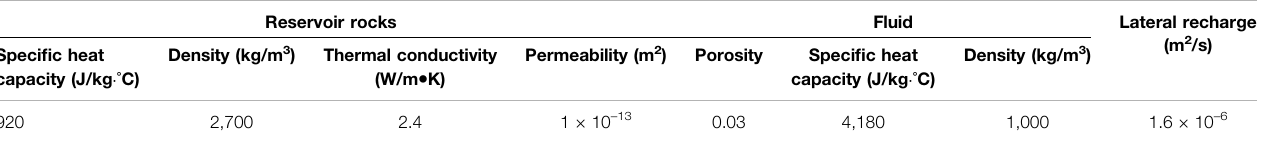
TABLE 1 | Main parameter values in the numerical model.